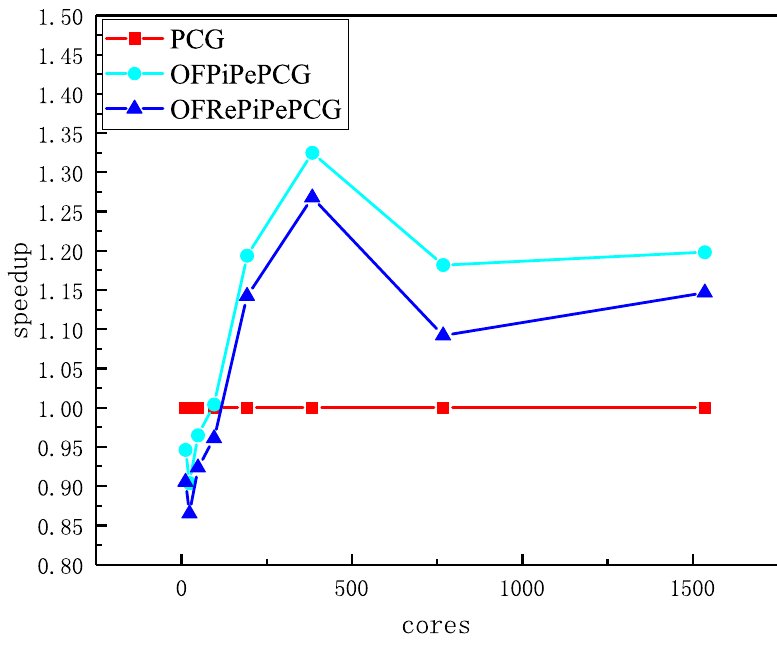
Figure 13. Weak scaling speedups relative to PCG (cavity).